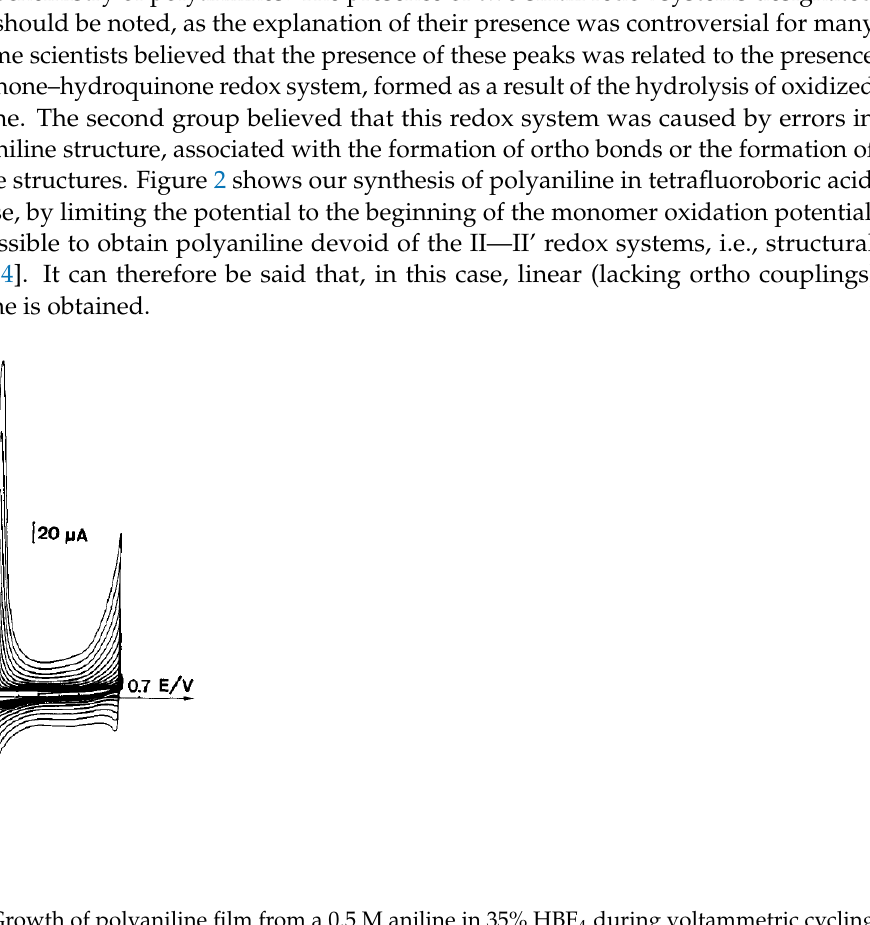
Figure 2. Growth of polyaniline film from a 0.5 M aniline in 35% HBF 4 during voltammetric cycling at 50 mV s −1 . Reprinted from [34], Copyright 1990, with permission from Elsevier.